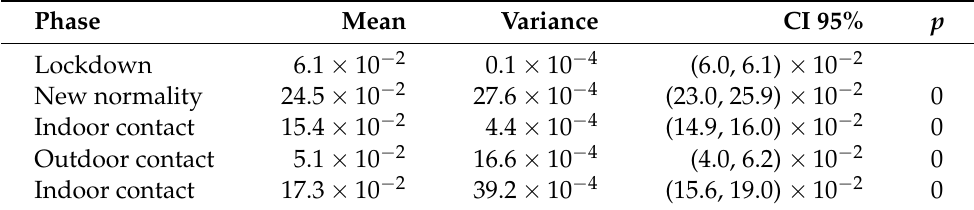
Table 13. Histogram for the mean values of β E at the different stages of lockdown in